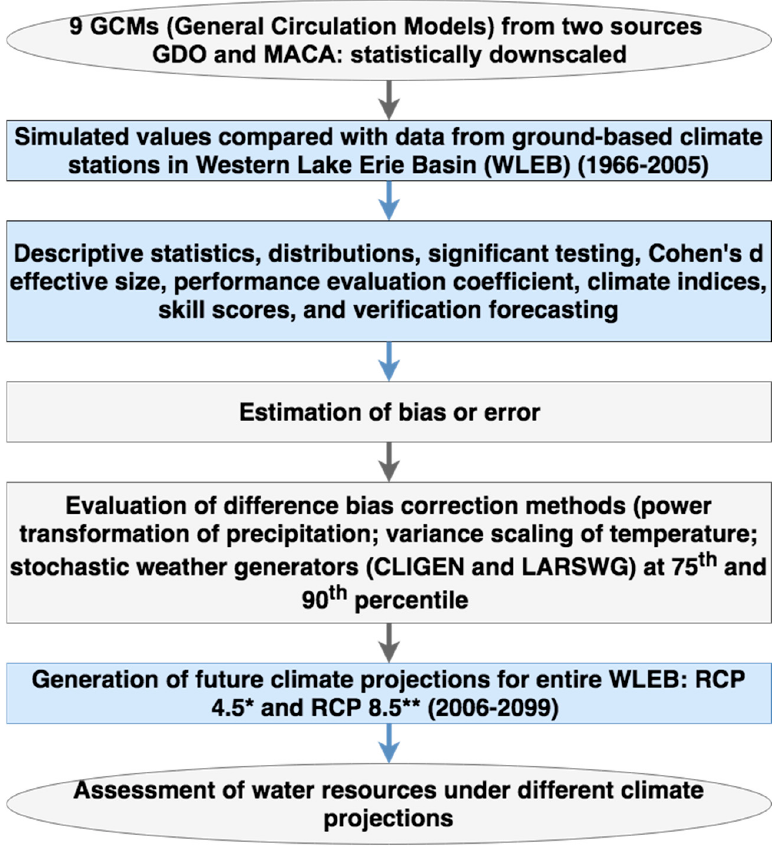
Figure 2. ( A ) Temporal distribution of daily precipitation records (mm), for ( a ) Adrian, MI; ( b ) Fort Wayne, IN, and ( c ) Norwalk, OH from 1966 to 2015 from the respective ground-based weather stations. Red boxes show the greatest magnitude precipitation event for each station. ( B ) Executive summary of the methodology. *;**: RCP: Representative Concentration Pathways (Radiative forcing); Currently: 300–400 ppm; RCP 4.5: 4.5 W/m 2 ; RCP 8.5: 8.5 W/m 2 .